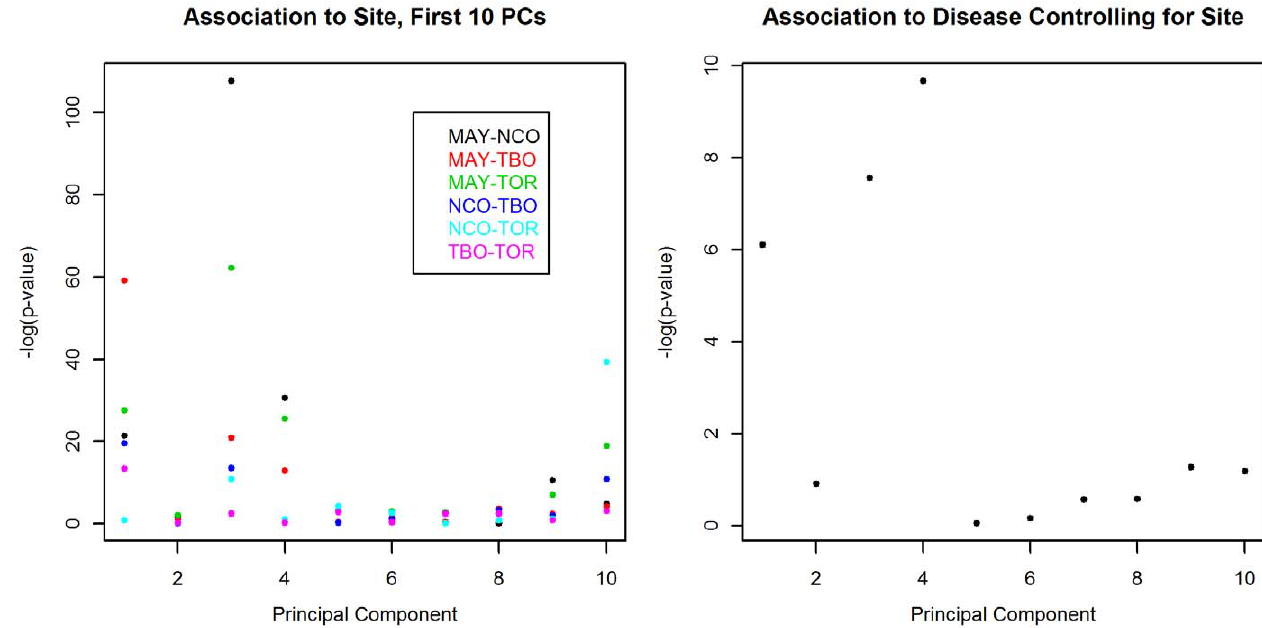
Figure 2. Association to site and to disease controlling for site of first 10 PCs in GWAS PCA. P-values for all pair-wise comparisons among four sites are given.